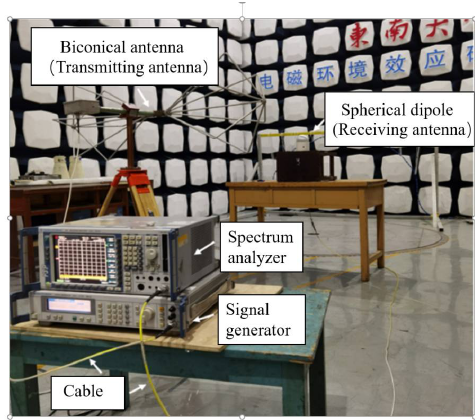
Figure 16. The actual layout of the reference test of the cavity shielding effectiveness (horizontal polarization of the biconical antenna).